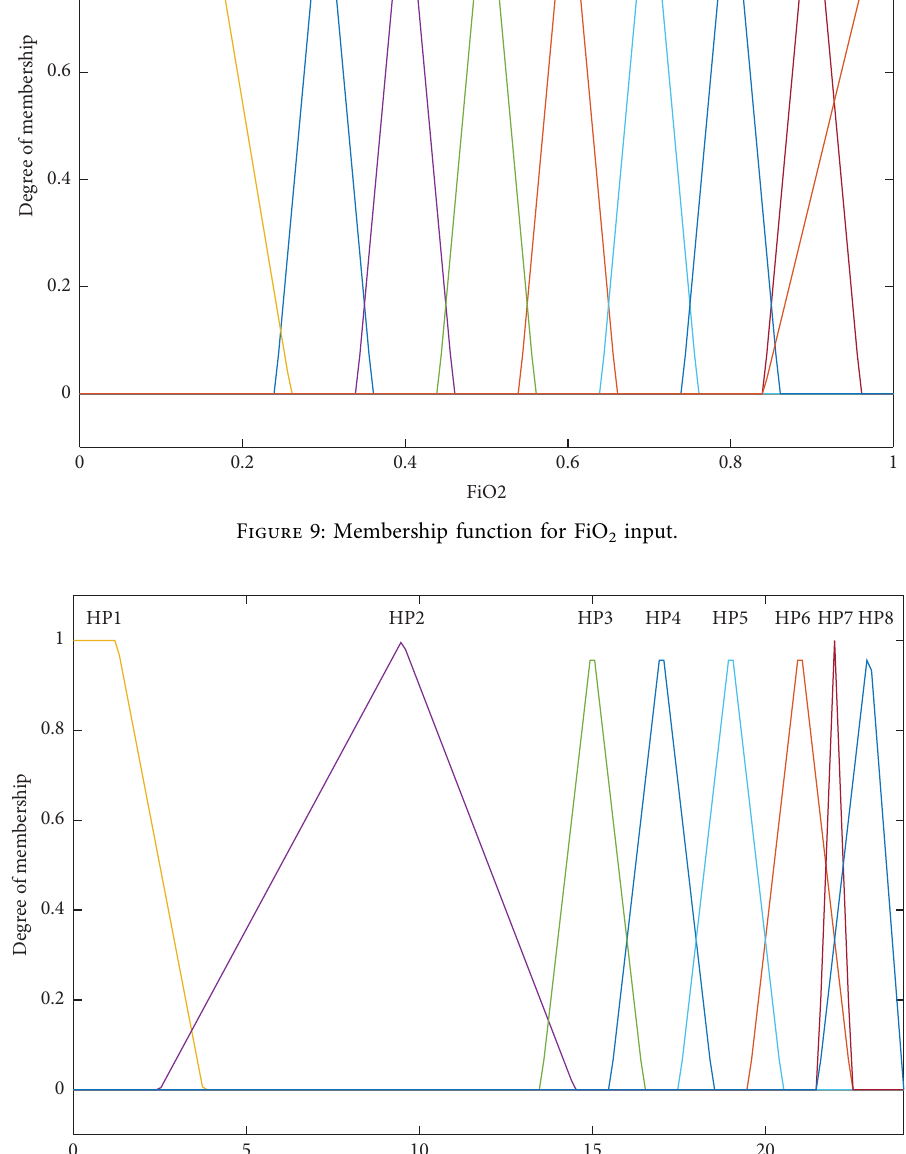
Figure 10: Membership function for high PEEP